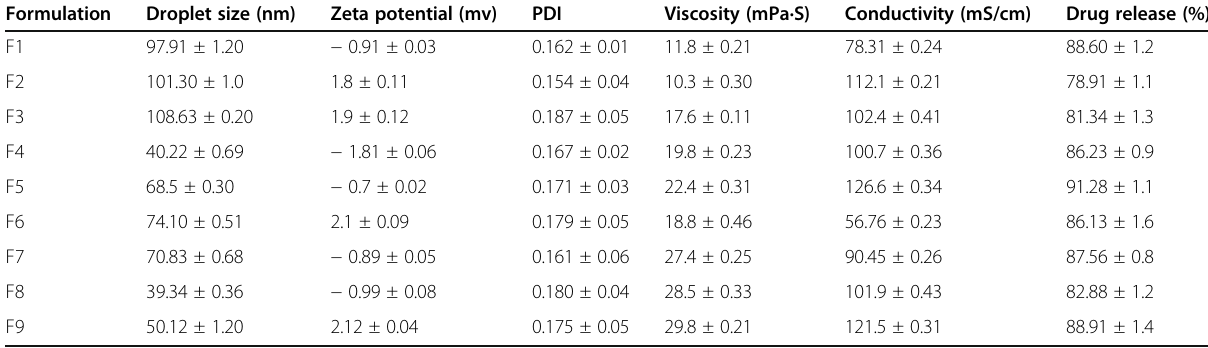
Table 2 Characterization of primaquine loaded nanoemulsion